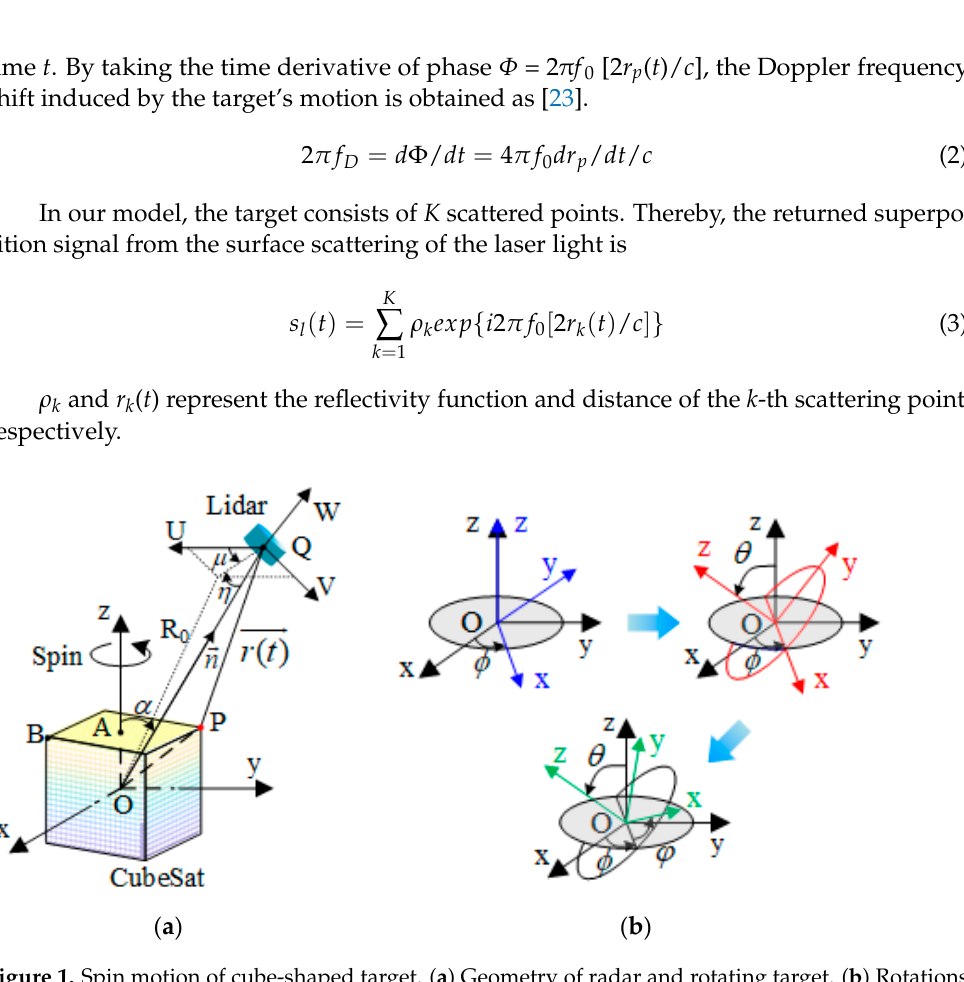
Figure 1. Spin motion of cube-shaped target. ( a ) Geometry of radar and rotating target. ( b ) Rotations by Euler angles ( ϕ , θ , φ ).